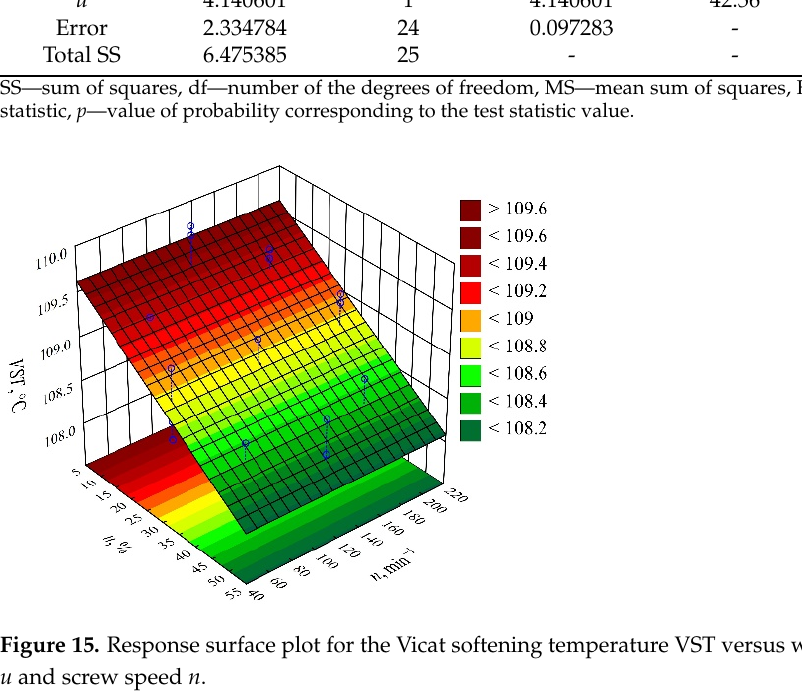
Figure 15. Response surface plot for the Vicat softening temperature VST versus wheat bran content u and screw speed n . u and screw speed n